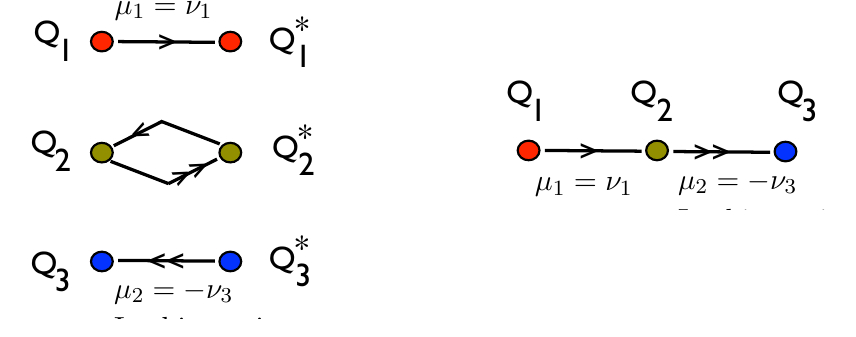
Figure 3 . Strings in SU(3) Seiberg-Witten theory. Left panel: Q i Q quarks are non degenerate, due to existence of only two ANO (cid:13)ux tubes (denoted by lines with a single or double arrow) carrying electric (cid:13)uxes (cid:22) 1 and (cid:22) 2 (notice that (cid:23) 2 = (cid:22) 2 Right panel: only linear baryons exist in Seiberg-Witten theory. Similar pictures hold for any number of colors.